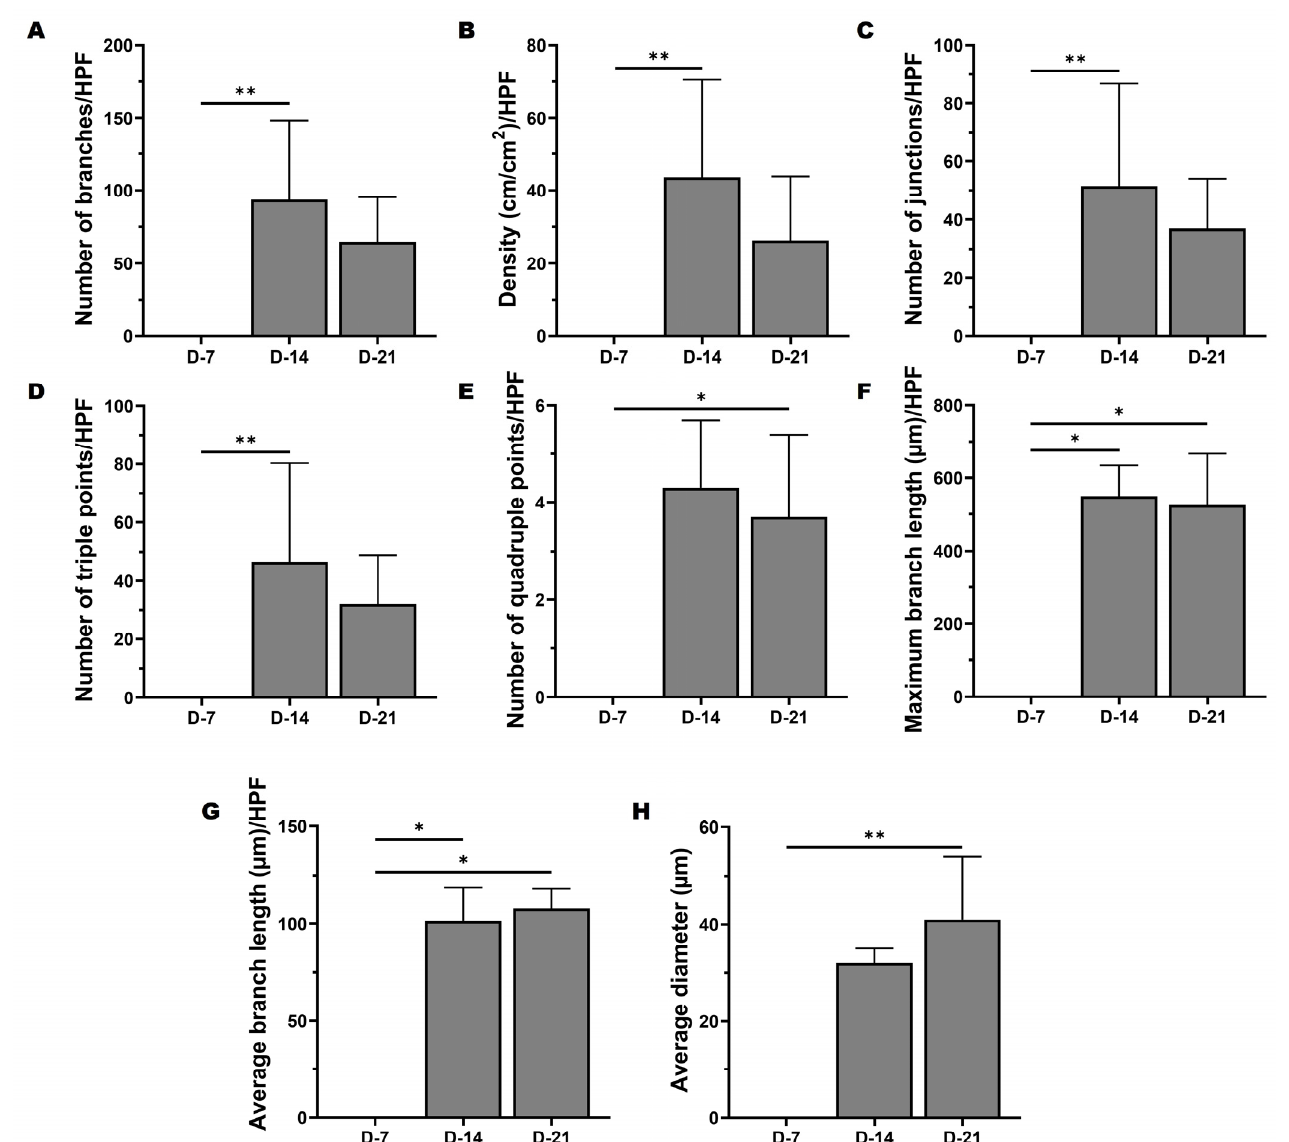
Figure 5. Chamber B IVM analysis. ( A ) Number of branches. ( B ) Density (cm/cm 2 ). ( C ) Number of junctions. ( D ) Number of triple points. ( E ) Number of quadruple points. ( F ) Maximum branch length. ( G ) Average branch length ( µ m) per HPF and ( H ) average vascular diameter ( µ m) were calculated. Data are presented as medians with interquartile ranges. Significance at * p < 0.05 and ** p < 0.01.